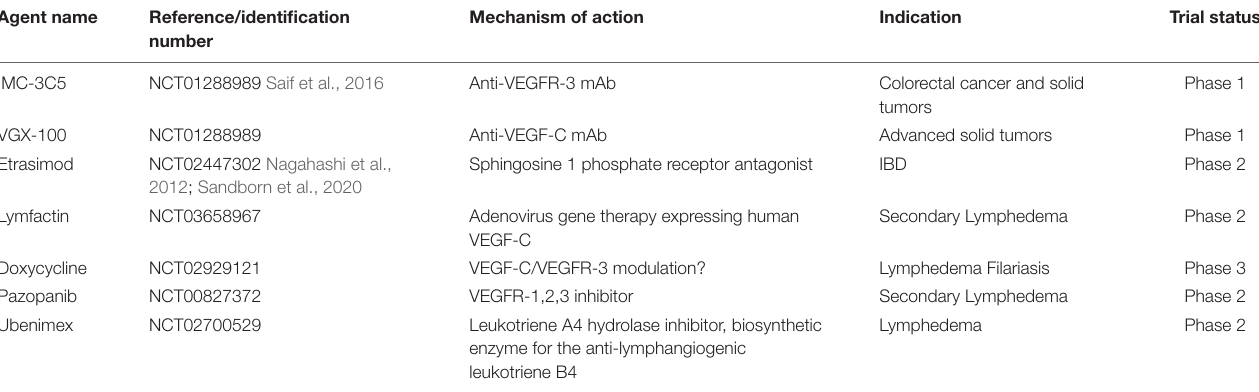
TABLE 5 | Lymphangiogenic modulatory agents tested in clinical